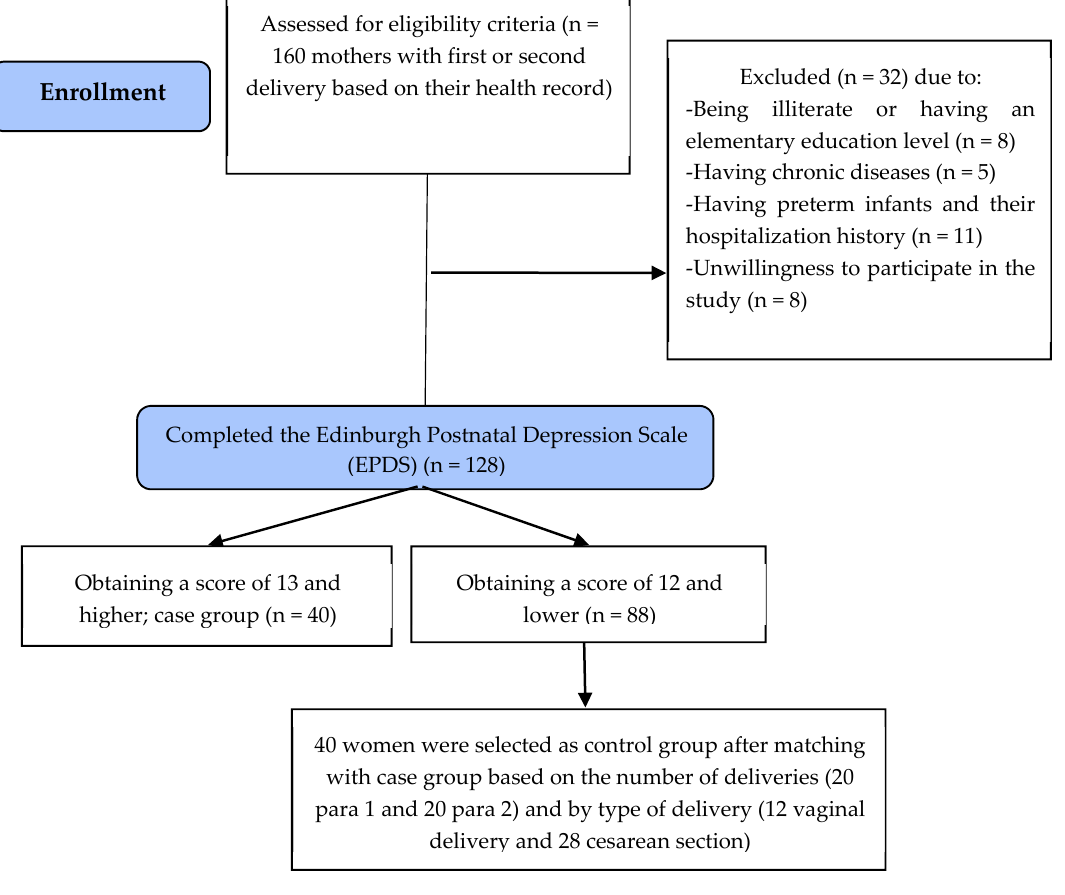
Figure 1. Flowchart of the study